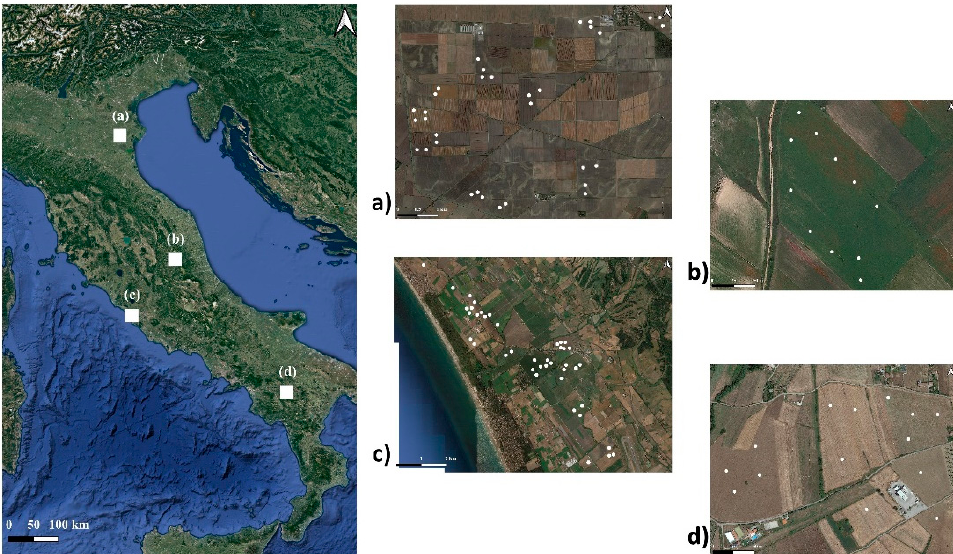
Figure 1. Distribution of sampling sites. ( a ) Jolanda di Savoia, Ferrara (JOL); ( b ) Castelluccio da Norcia, Perugia (CAST); ( c ) Maccarese, Roma (MAC); ( d ) Pignola, Potenza (PIG). The white dots represent the sampling sites; in some cases, two soil samples were collected some meters apart within the sampling site to check short-range soil variability.